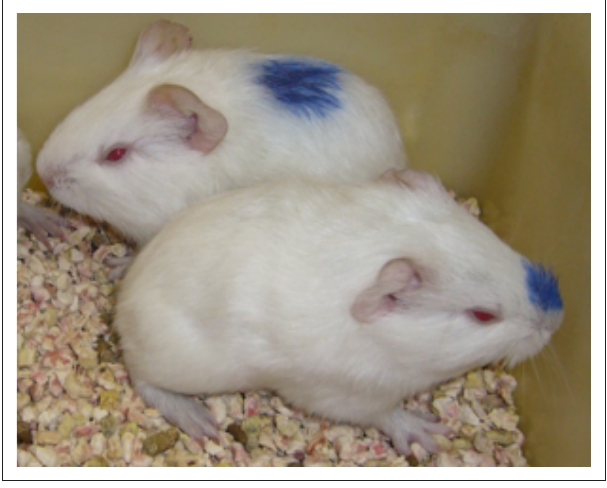
Source : Photographed by R.A. Schultz FIGURE 6: Guinea pig 36 h after dosing with diplonine, exhibiting lateral recumbency (severely affected).